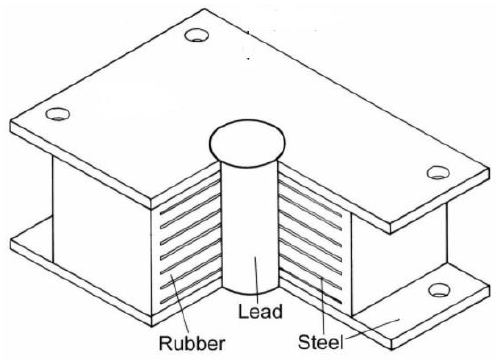
Figure 1. Lead Rubber Bearing [1].